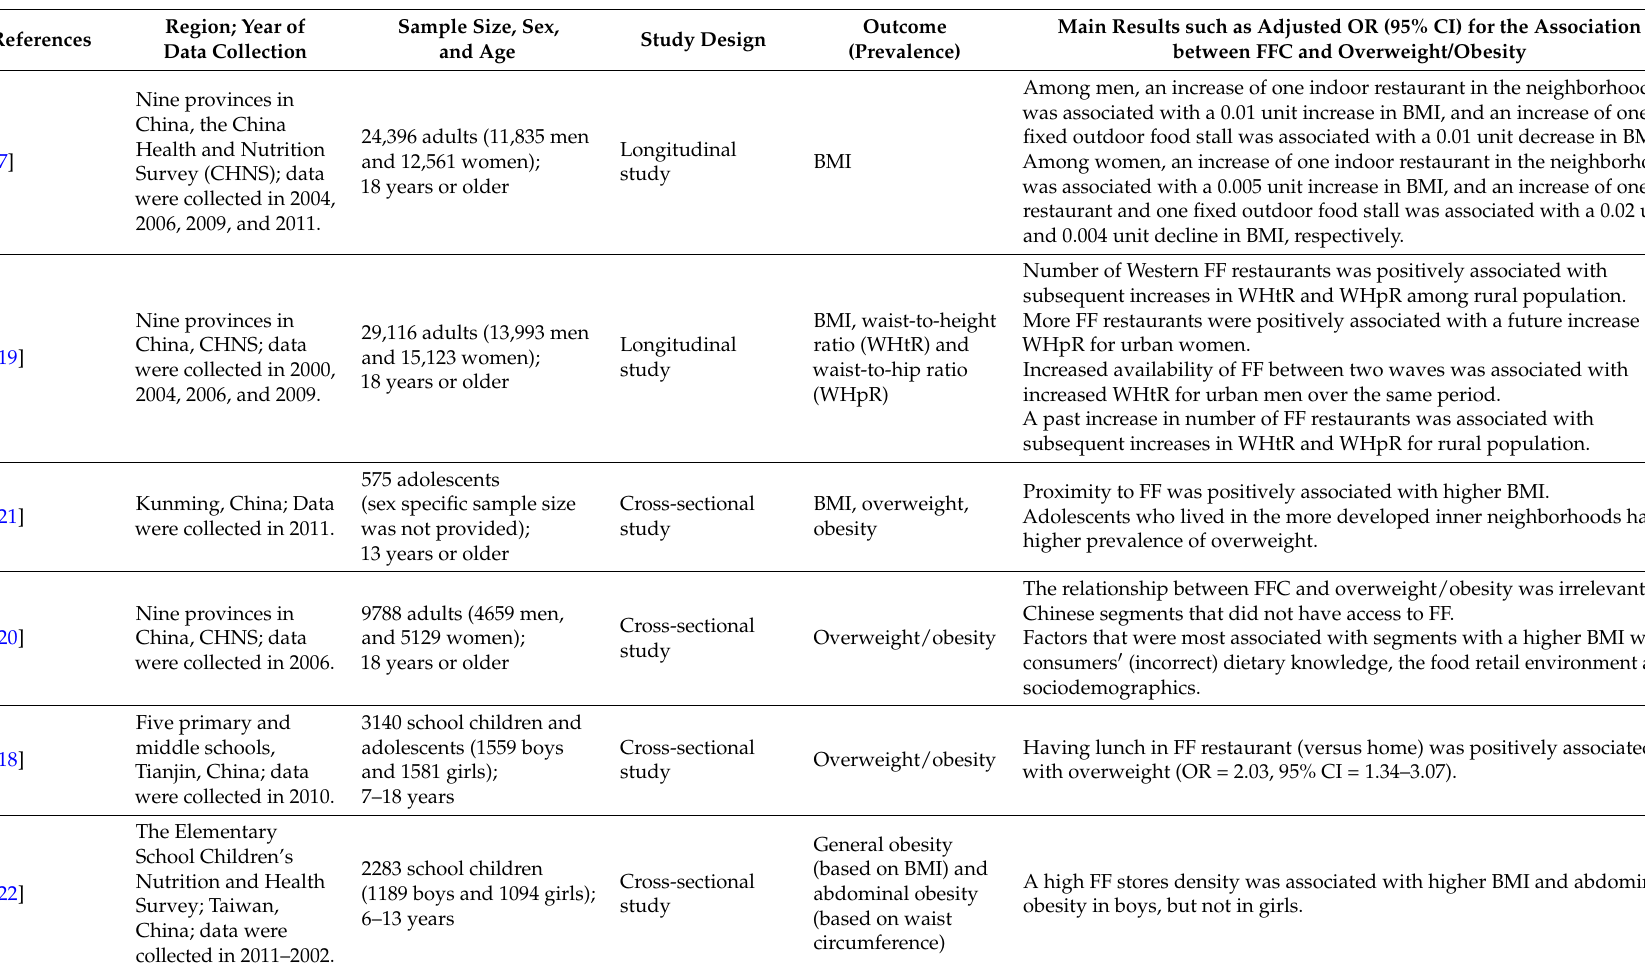
Table 2. Key study characteristics and findings regarding the association between fast food consumption (FFC) and obesity in